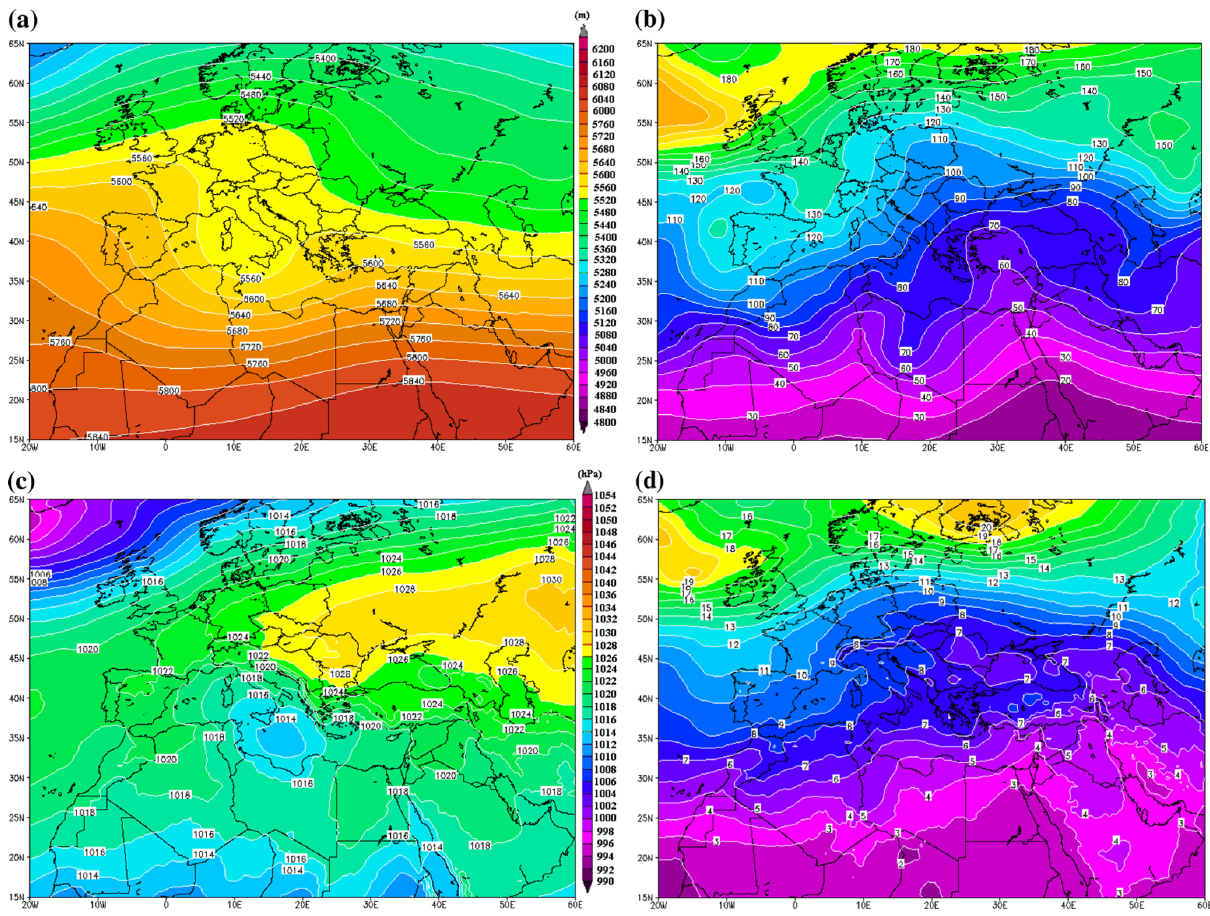
Fig. 8. Composite field of ( a ) 500hPa geopotential height (at 40m contour intervals) and ( c ) mean sea level pressure field (at 2hPa contour intervals) with their corresponding standard deviation fields ( b ) and ( d ),